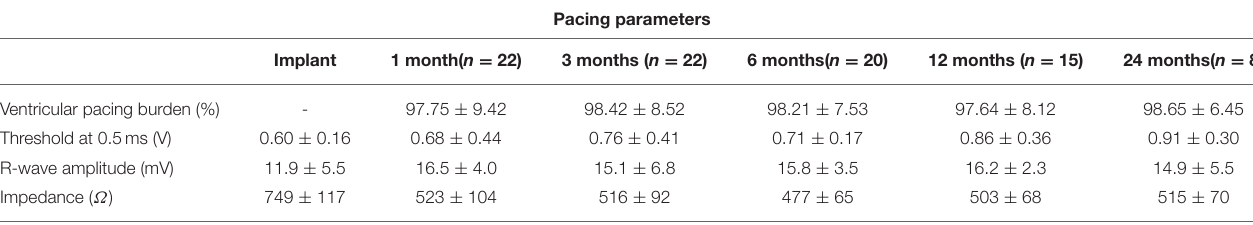
TABLE 2 | Pacing parameters at implant and follow-up.